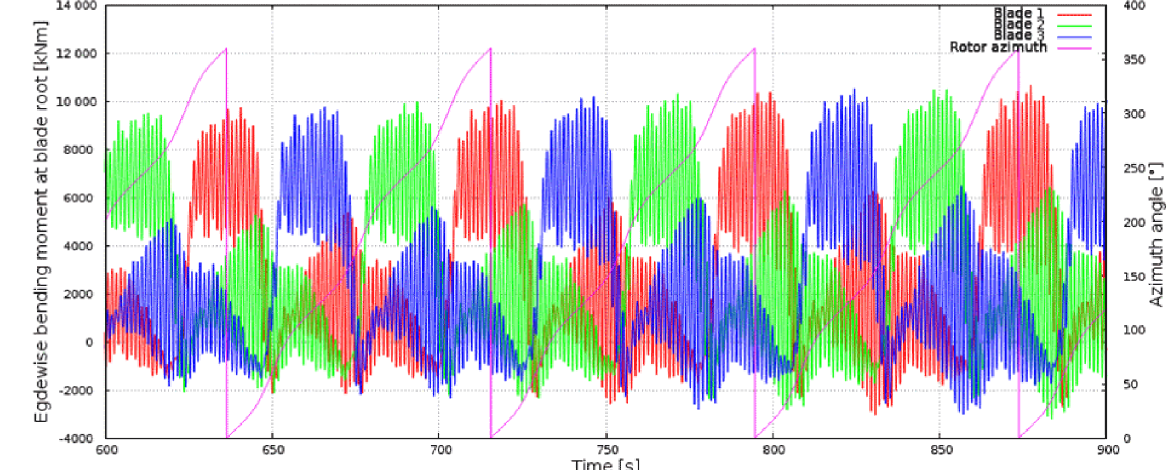
Figure 22. Time series of the edgewise bending moment at the blade root with uniform inflow at U = 42 . 5ms − 1 and yaw = 30 ◦